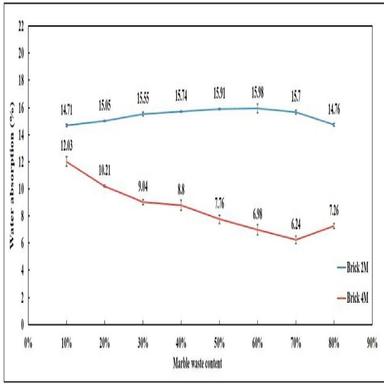
Water absorption percentage of hybrid geopolymeric composite samples prepared at different molarities and marble waste content.